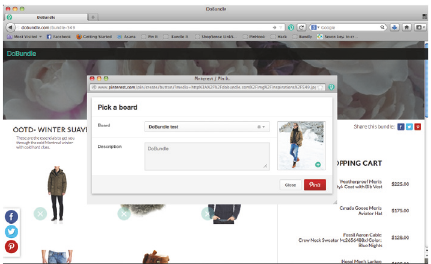
Figure 11: A screenshot of Pinterest pulling the stamped image to share on its